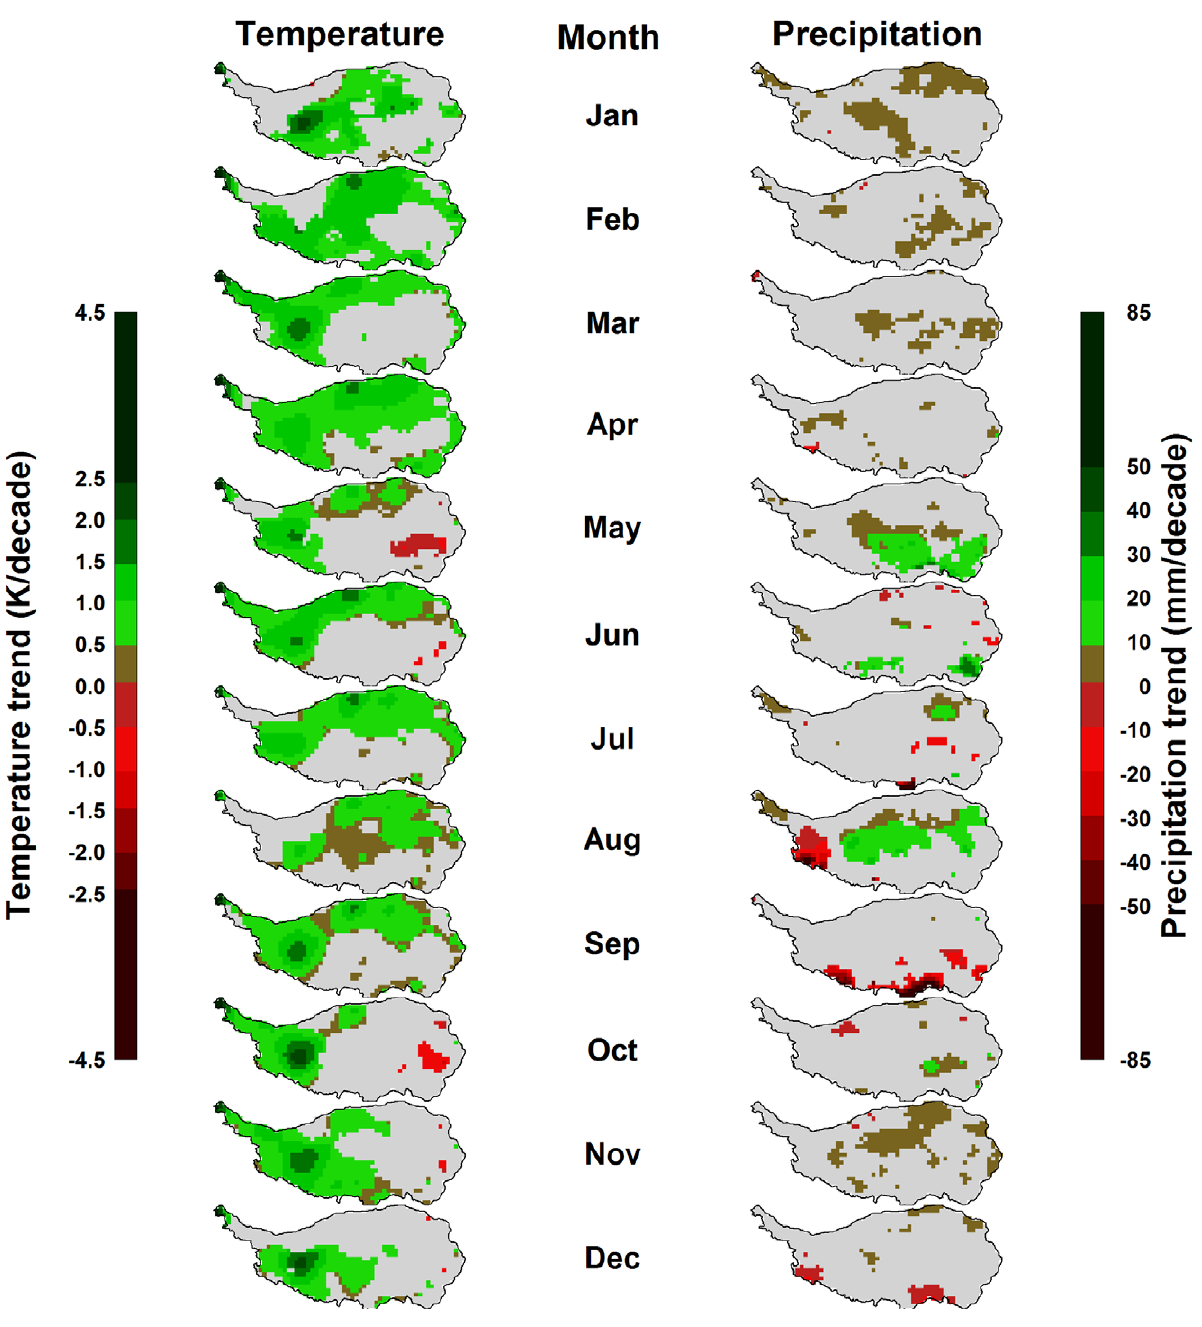
Figure 4. Trends in monthly mean temperature (left) and precipitation (right) on the Tibetan Plateau between 1982 and 2006. Gray areas indicate regions, for which no significant trends were detected by the Mann-Kendall test at p ,